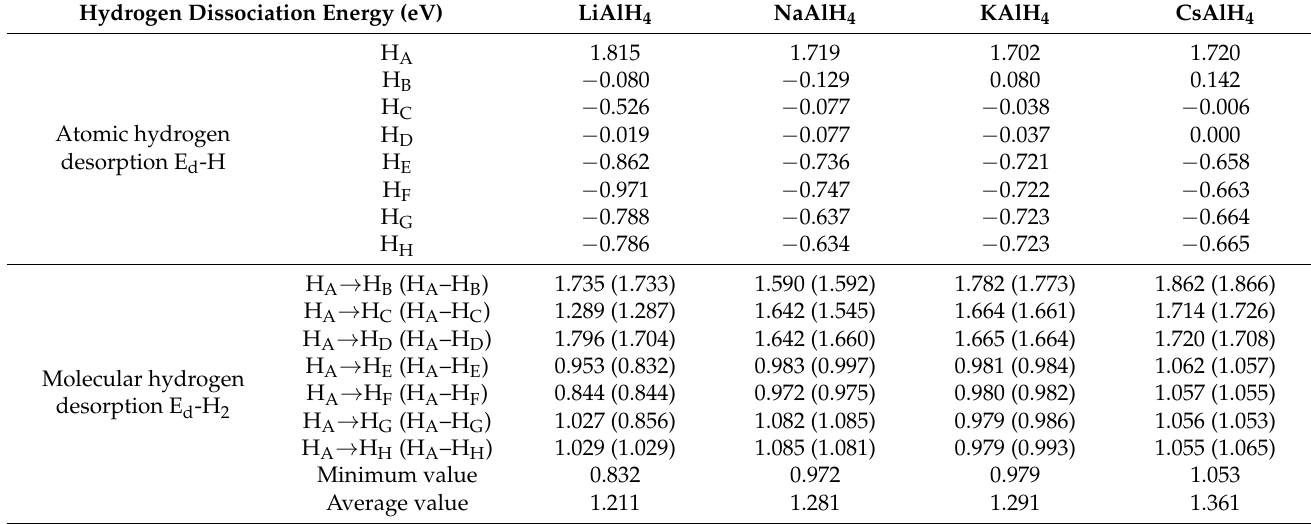
Table 2. The hydrogen dissociation energy of MAlH 4 (M = Li, Na, K, and Cs), including atomic hydrogen dissociation energy (E d -H) for H A and H X (H B , H C , H D , H E , H F , H G , H H ) desorption and molecular hydrogen dissociation energy (E d -H 2 ) for H A → H X (outside the bracket) and H A –H X desorption (inside the bracket). The minimum and average values of all E d -H 2 are also